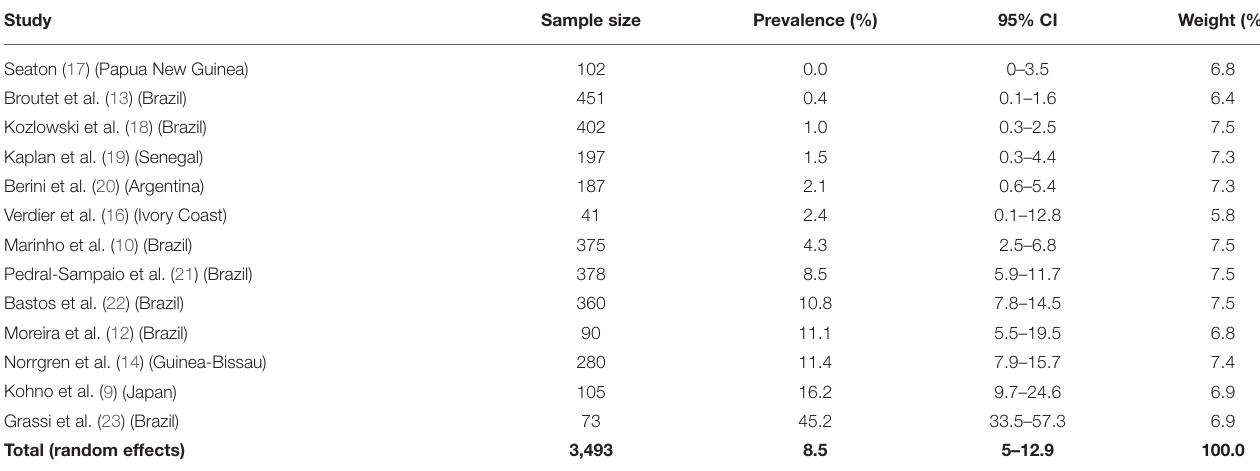
TABLE 1 | Prevalence of HTLV-1 infection in patients with M. tuberculosis